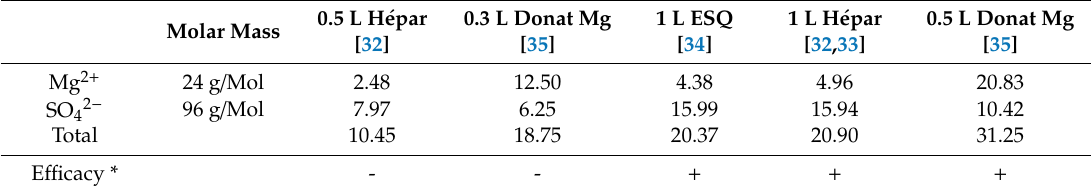
Table 5. Magnesium and sulfate consumed daily by the patients